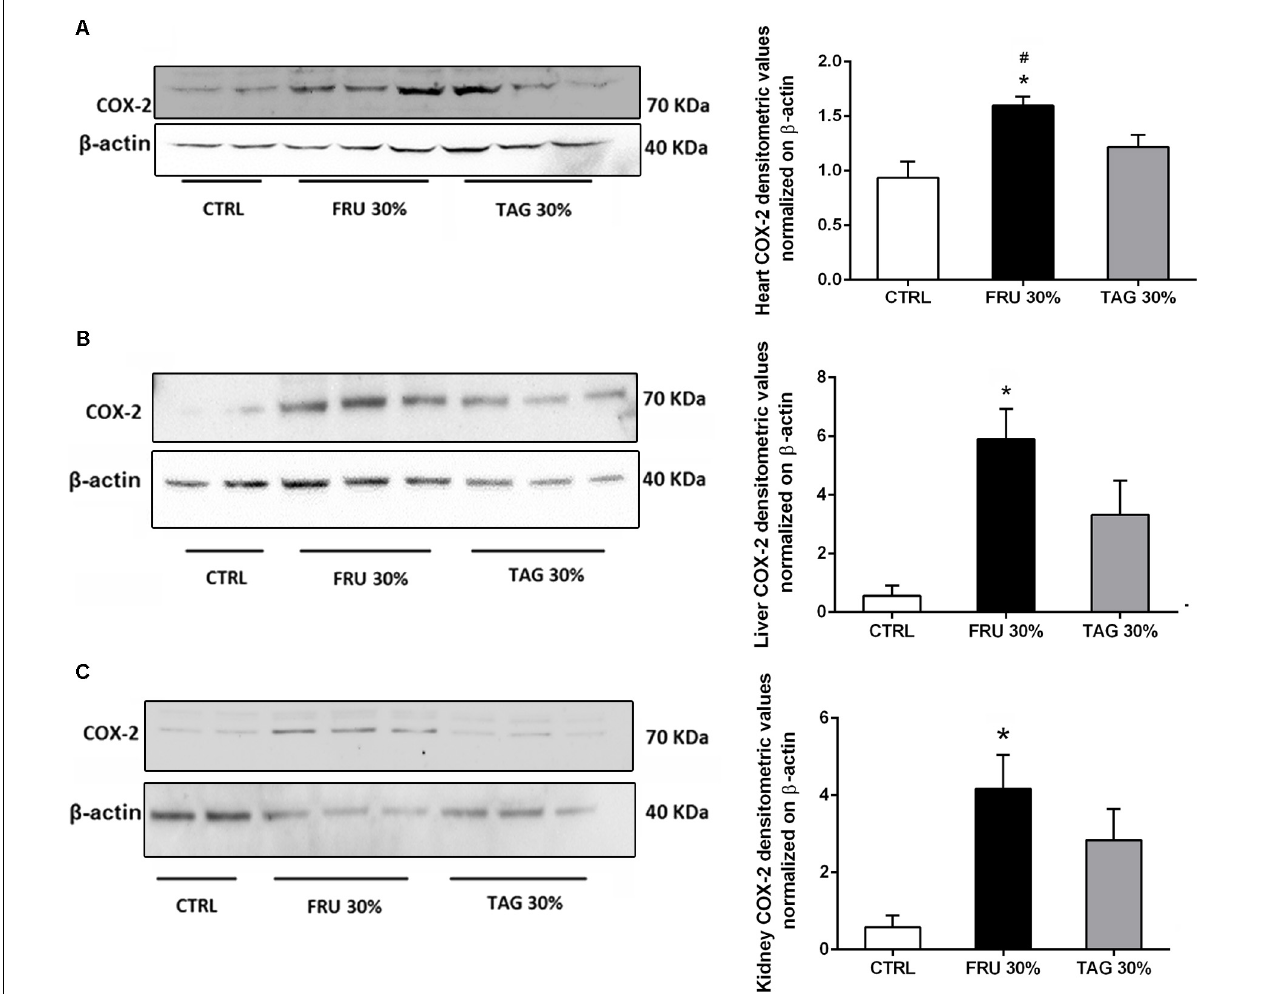
FIGURE 7 | Impact of sugar feeding on myocardial, hepatic and renal expression of cyclooxygenase-2 (COX-2) enzyme isoform. Representative immunoblot and densitometric analysis of the expression of COX-2 in heart (A) , liver (B) , and kidney (C) of rats fed with CTRL, FRU 30% or TAG 30%. Densitometric data are reported as relative optical density (OD), corrected for the corresponding β -actin contents. Data are means ± SD for 8 (CTRL and TAG 30%) and 7 (FRU30%) samples per group; * p < 0.05 vs. CTRL; # p < 0.05 vs. TAG 30%.